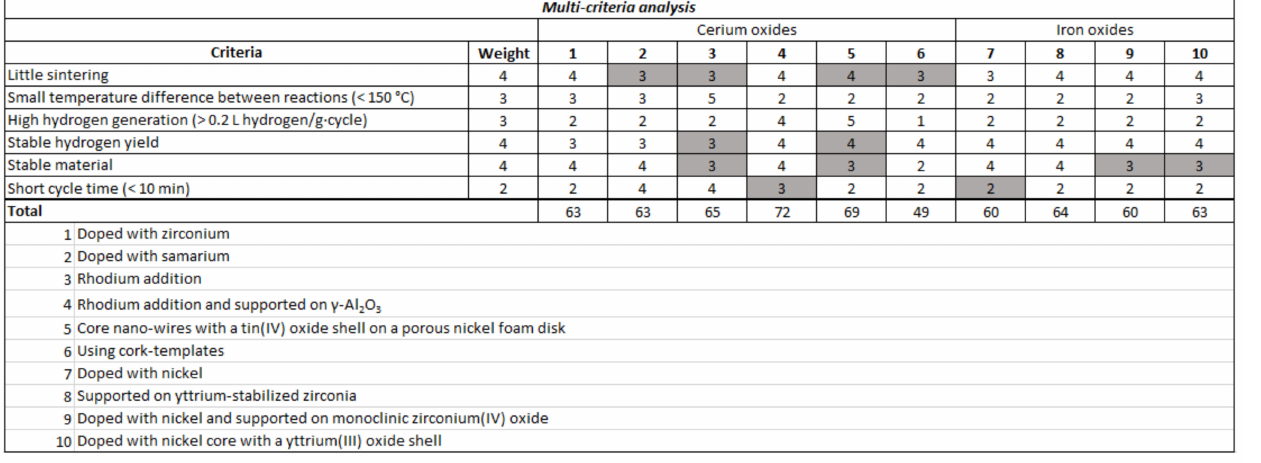
Figure 16. Multi-criteria analysis including the criteria and weights of the redox materials suitable for thermochemical two-step water